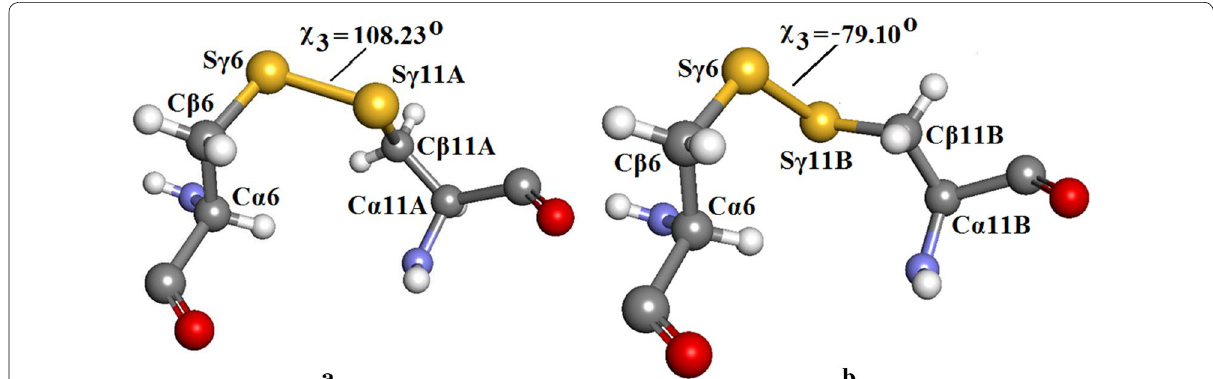
Fig. 14 a Insugen (I) structure: chain C(3) S–S bridge between Sγ6 and Sγ11 showing the geometry of the major conformation part A of the disor‑ dered S–S bridge in chain C(3). b Insugen (I) structure: chain C(3) S–S bridge between Sγ6 and Sγ11 showing the geometry of the minor conforma‑ tion part B of the disordered S–S bridge in chain C(3). Drawn with Accelrys Discovery Studio 3